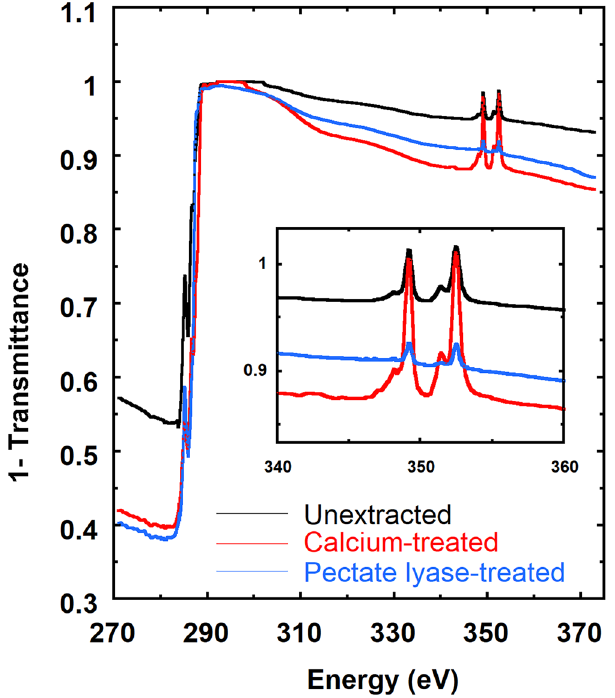
Figure 3. NEXAFS spectra of unextracted, calcium-treated, and pectate lyase-treated onion 11 th scale epidermis. Inset: NEXAFS spectra between 340 eV and 360